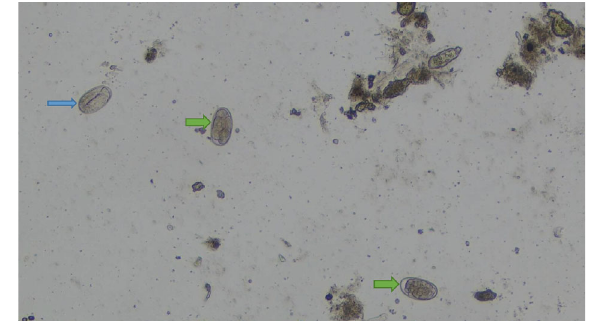
Figure 2: Strongyle -egg type (blue arrow) and Entameoba cyst (green arrow).